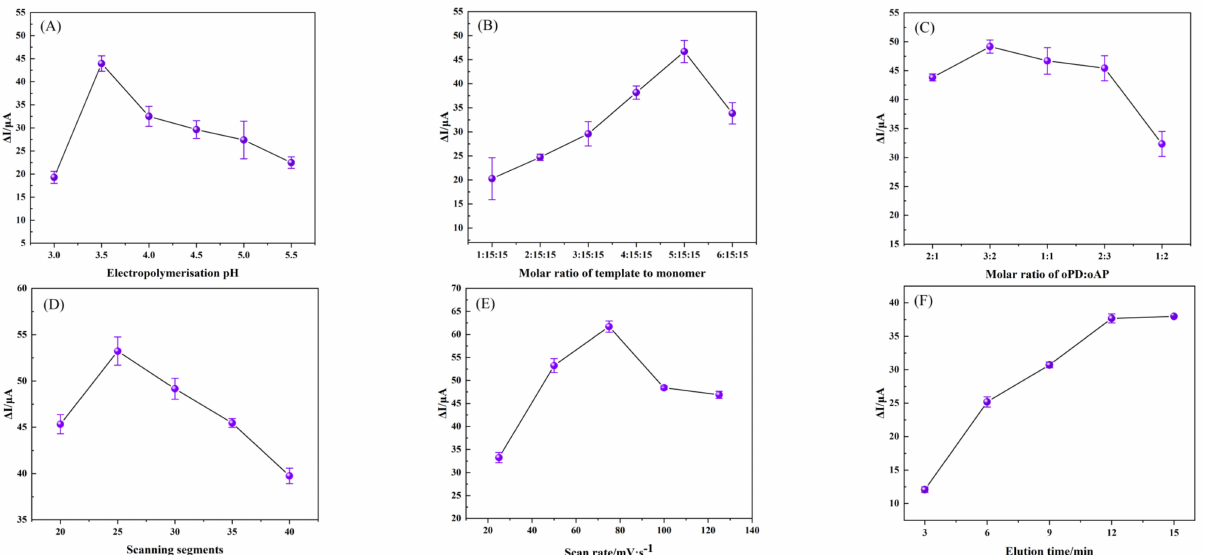
Figure 7. The plots for the relationship of ( A ) background pH of electropolymerization, ( B ) molar ratio of template to monomer, ( C ) molar ratio of oPD:oAP, ( D ) scanning segments, ( E ) scan rate and ( F ) elution time on the current difference ( ∆ I) by DPV in 5 mmol · L − 1 [Fe (CN) 6 ] 3 − /4 − (1.0 mol · L − 1 KCl). ∆ I = I 0 − I 1 , I 0 and I 1 were the peak currents obtained from MIP/TBC/GCE before and